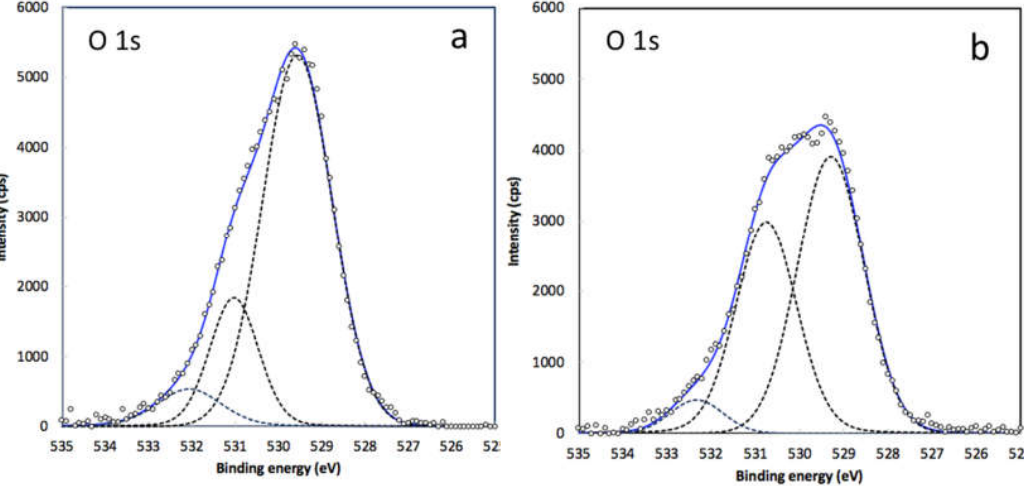
Figure 10. Oxygen (O 1s) XPS spectra of ( a ) unreacted MnO2 and ( b ) Cr(III)-treated MnO 2 . Dashed lines are the Gaussian– Lorentzian fit peaks described in Table 1, and the solid line is the sum-fit line.